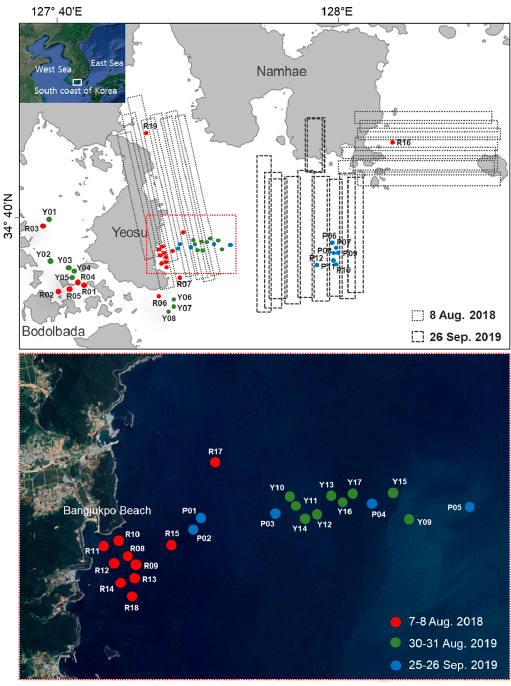
Figure 1. The study area along the south coast of Korea used for quantification of Margalefidinium polykrikoides blooms. Red, green, and blue dots indicate the sampling locations of field surveys Black boxes show the flight routes of airborne monitoring surveys used to acquire hyperspectral imagery (HSI) at the time of the field surveys. The red box shows an enlarged view of the sampling locations near Bangjukpo Beach in Yeosu ( bottom